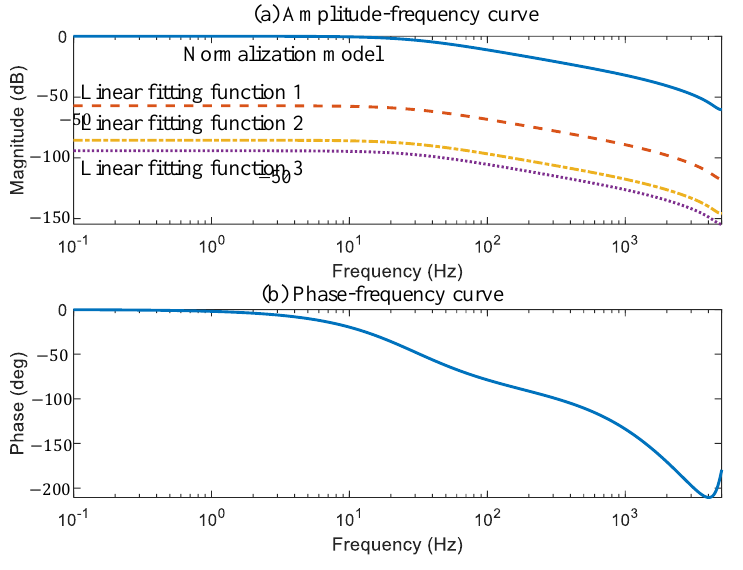
Figure 9. The fitted model for dynamic behavior. Connected with Equation (14), the linear time-varying model Equation (11) is reached after linearization at time t